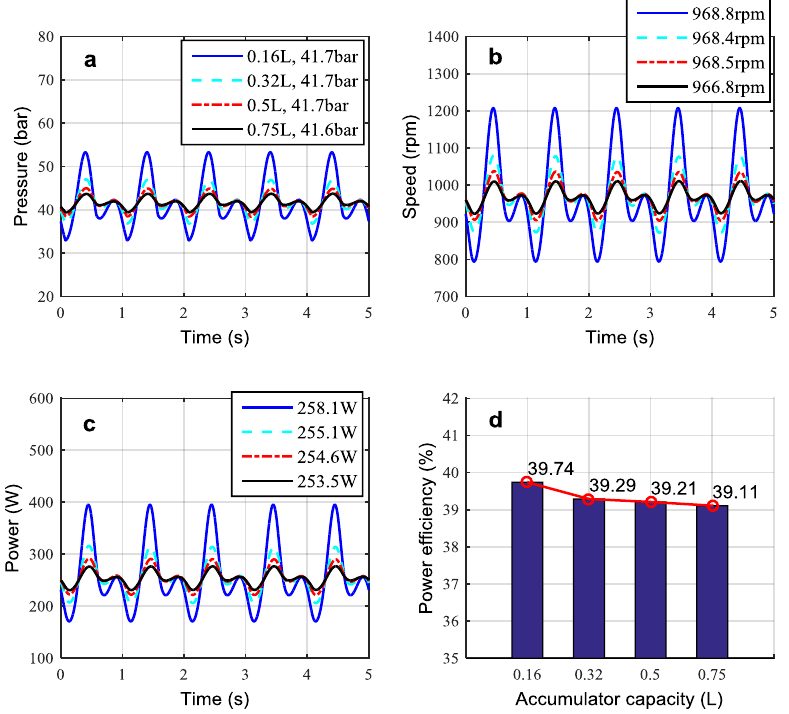
Figure 16. ( a ) Predicted motor pressure; ( b ) predicted shaft speed; ( c ) predicted regenerative power; ( d ) predicted power regeneration efficiency, at 0.16 L, 0.32 L, 0.50 L and 0.75 L accumulator capacities.